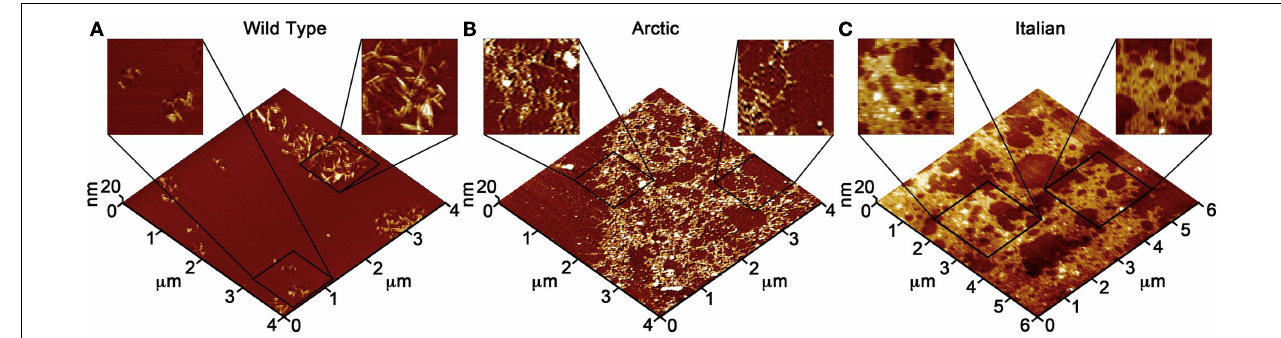
bilayer with perturbed morphology (an increase in surface roughness). (B) While many small oligomers of Arctic A β were observed on the bilayer, highly curved fibrils that were associated with membrane disruption were the dominant aggregate species.These Arctic A β fibrils were morphologically distinct from fibrils observed forWildType A β . (C) While Italian A β also formed similar oligomers comparedWildType and Arctic A β , large patches of disrupted bilayer morphology developed that may be associated with distinct fibril